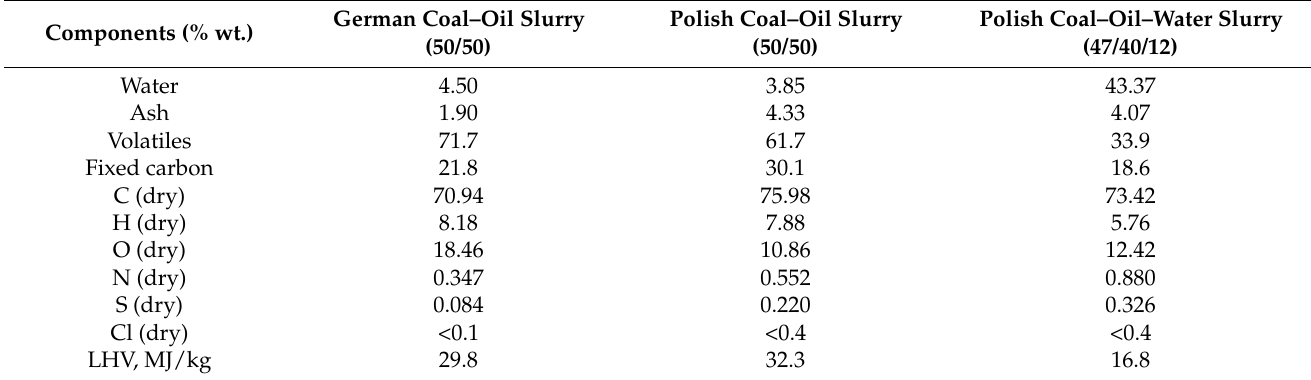
Table 2. Typical composition data for COS